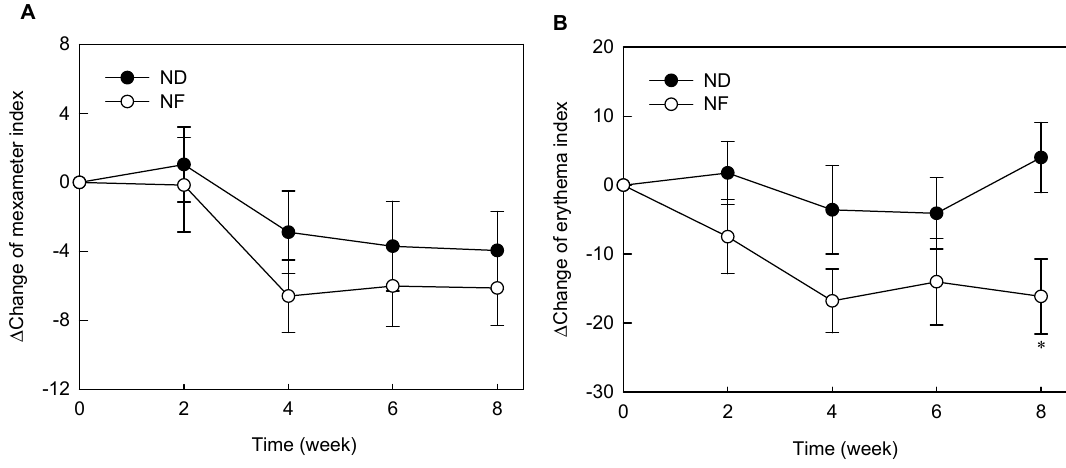
Figure 2. Effects of serum cosmetics containing GOS on melanin index ( A ) and erythema index ( B ) from baseline after 8 weeks of treatment in healthy adults. The asterisks indicate significant differences (* p < 0.05) between the NF and the ND groups at the indicated week. The p of two-sided independent t-test method was displayed, and all data are reported as mean ± standard error of the mean. ND (control serum); NF (cosmetic serum containing GOS).